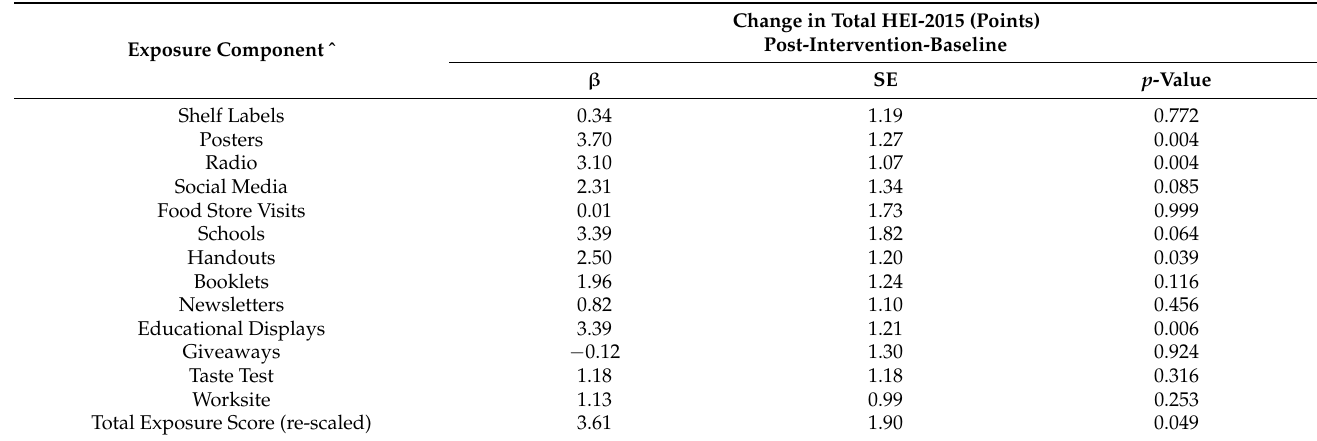
Table 3. Associations between exposure to OPREVENT2 and change in diet quality (Healthy Eating Index 2015 score, HEI-2015) ( n = 227)